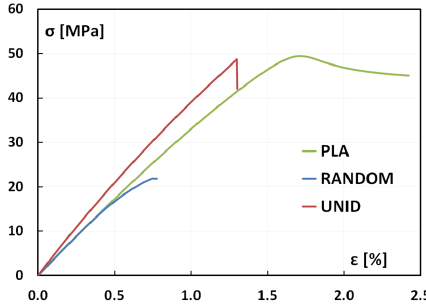
Figure 2. Stress ‐ strain curves obtained from quasi ‐ static tensile tests. UNID, unidirectionally; RANDOM, randomly.